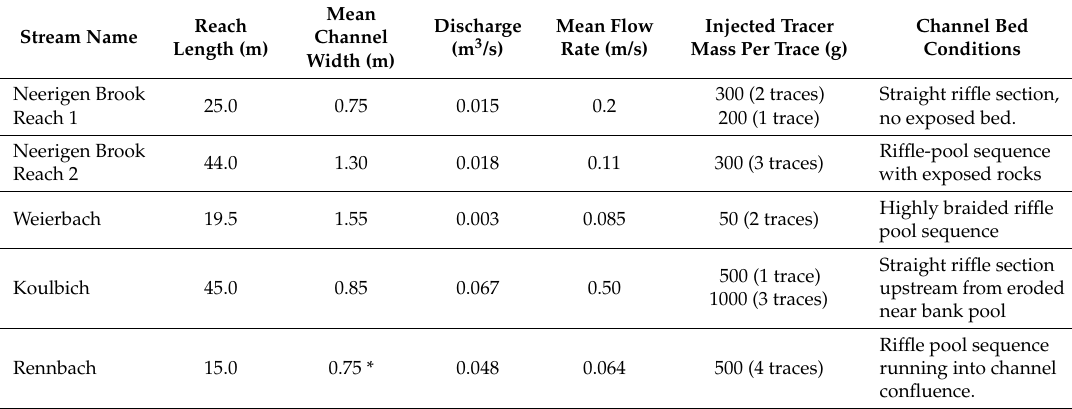
Table 1. Study reach characteristics, tracer injection details and bed